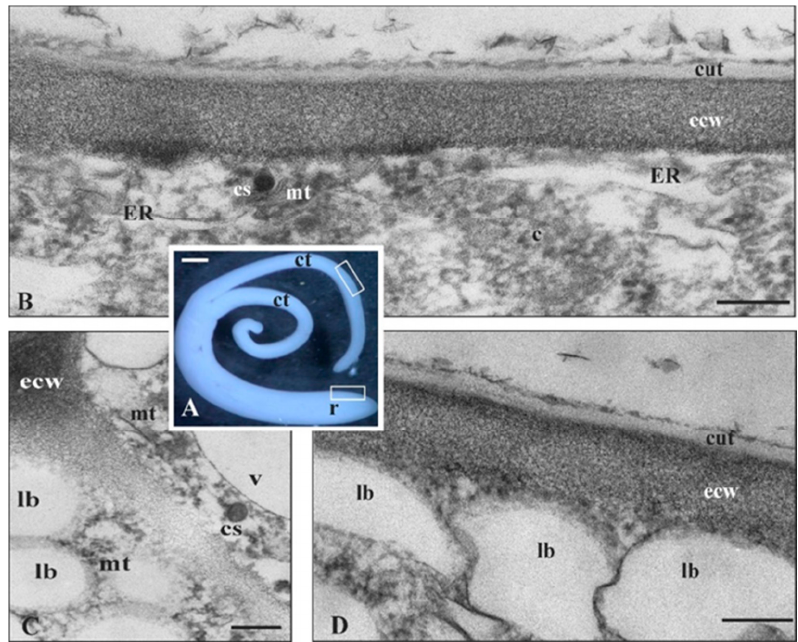
Figure 3. Cutinsomes in cuticle formation of S. lycopersicum embryo. ( A ) Mature embryo (frames show sites of studied material containing clear cuticle). TEM images of ( B ) cotyledon and ( C , D ) the radicle cup. Cutinsomes in ( B , C ) cytoplasm, near ( B , C ) plasmalemma travelling toward ( B , D ) the external cell wall in order to build a distinct layer of cuticle. ( B – D ) Material fixed in glutaraldehyde without OsO 4 ; c, cytoplasm; ct, cotyledons; cs, cutinsome; cut, cuticle; ecw, external cell wall; ER, endoplasmic